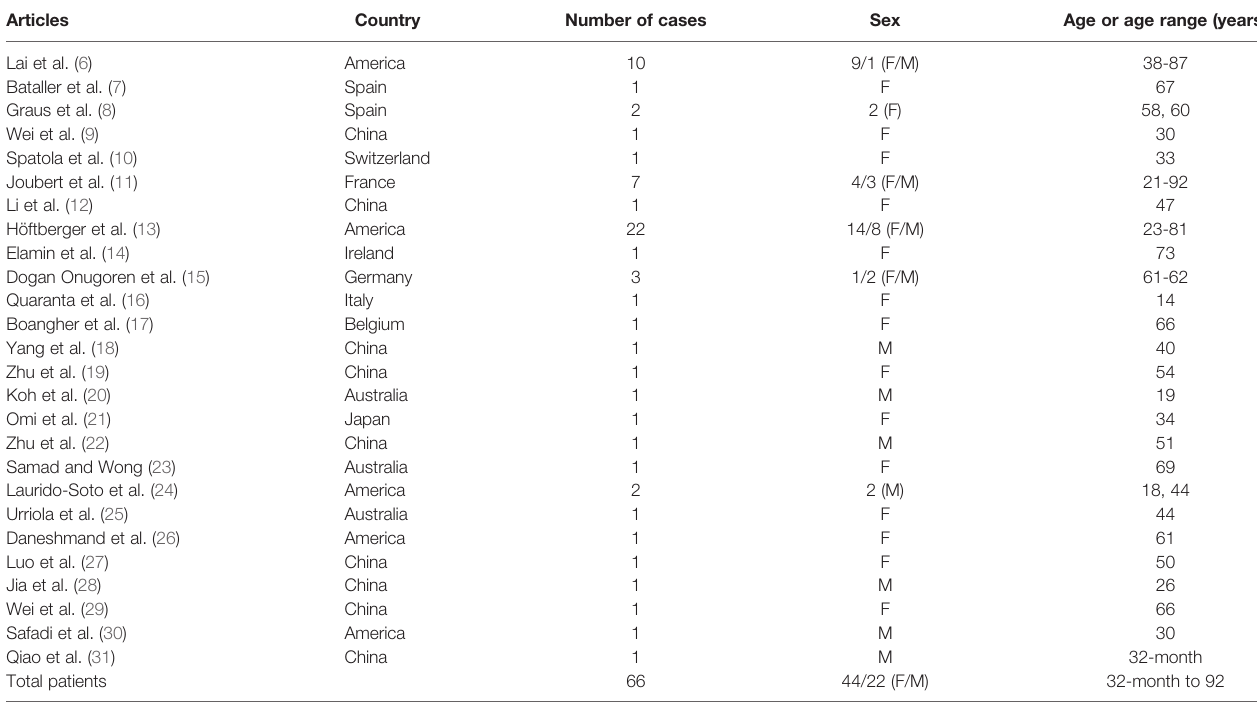
TABLE 1 | Summary of articles in the review (6 – 31). Articles Country Number of cases Lai et al.